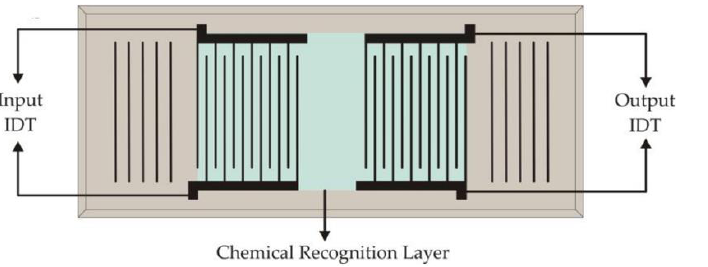
Figure 20. A fundamental schematic showing chemical and gas sensing applications using SAW devices [179].